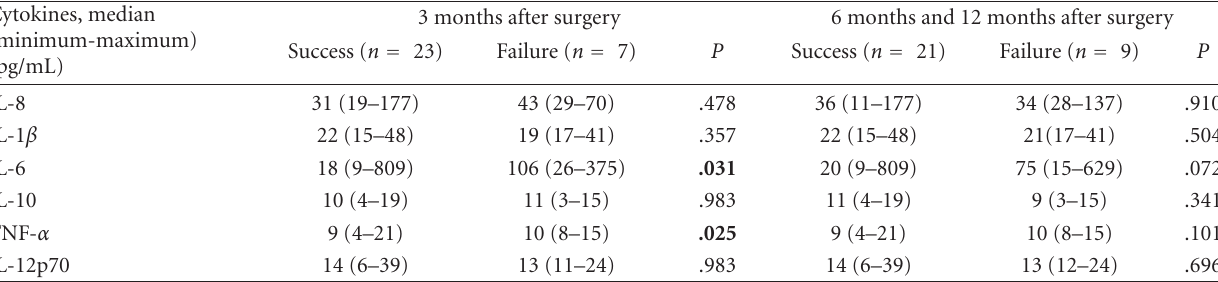
Table 3: Concentration of cytokines in aqueous humour in patients with successful and failed surgery at 3, 6, and 12 months of follow-up. Cytokines,